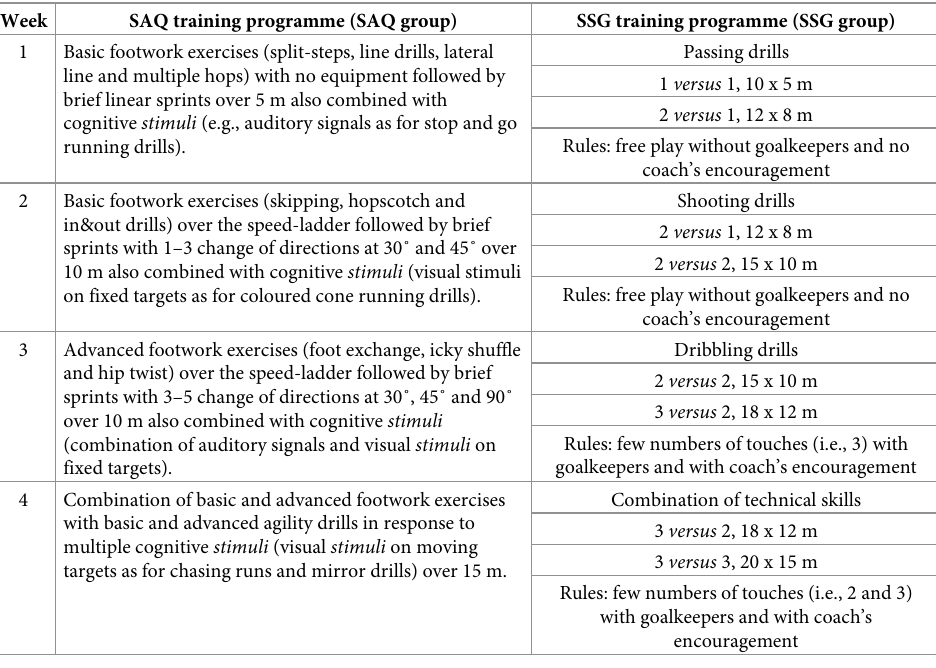
Passing drills Rules: free play without goalkeepers and no coach’s encouragement coach’s encouragement